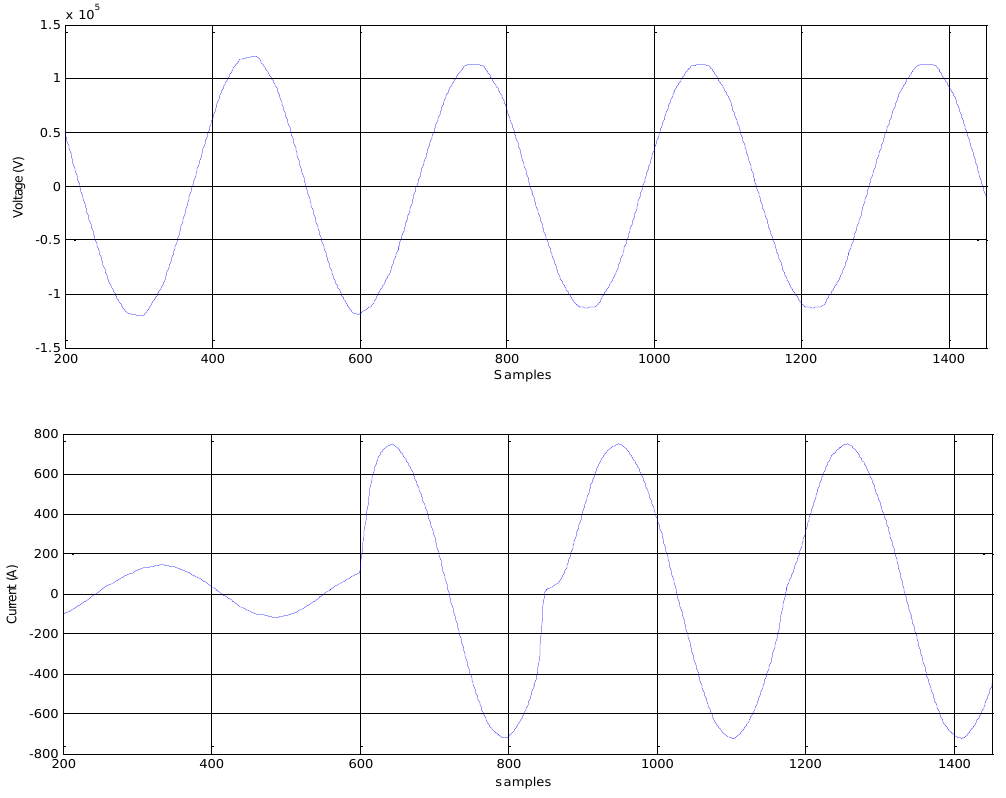
Figure 17. Voltage and current at the beginning of the feeder (output plot of krona-520 in MATLAB).